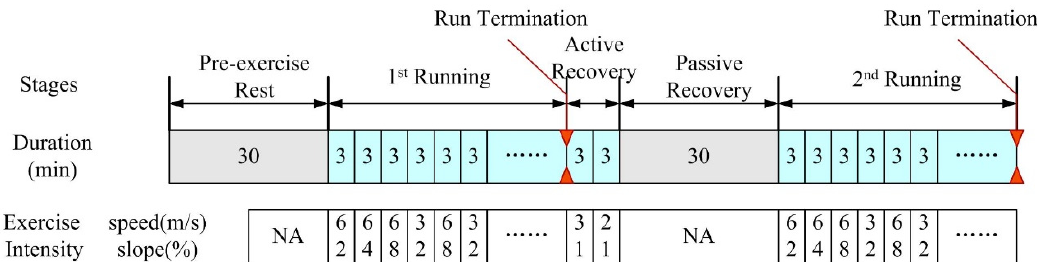
Figure 2. Protocol for the experiment. The 1 st and 2 nd run cycles terminate when T c (temperature of the core body) = 38.5 ° C, or HR (heart rate) = 0.95(220 − Age), or the subject requests to stop.